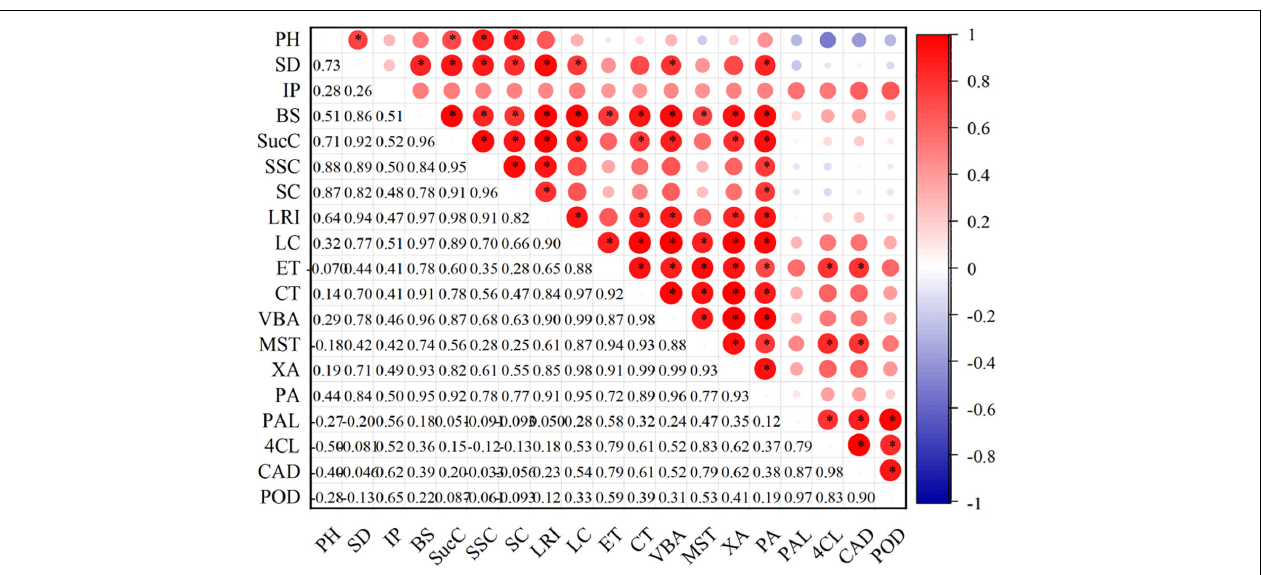
FIGURE 8 | Relationship between stem characteristics, lignin content, and related enzyme activities. Red represents positive correlation, and blue represents negative correlation (* p ≤ 0.05). The intensity of color represents the significance of a variable. PH, plant height; SD, stem diameter; IP, internode plumpness; BS, bending strength; SucC, sucrose content; SSC, soluble sugar content; SC, starch content; LRI, lodging resistance index; LC, lignin content; ET, epidermis thickness; CT, cortical thickness; VBA, vascular bundle area; MST, mechanical structure thickness; XA, xylem area; PA, pith area. PAL, phenylalanine ammonia-lyase activity;